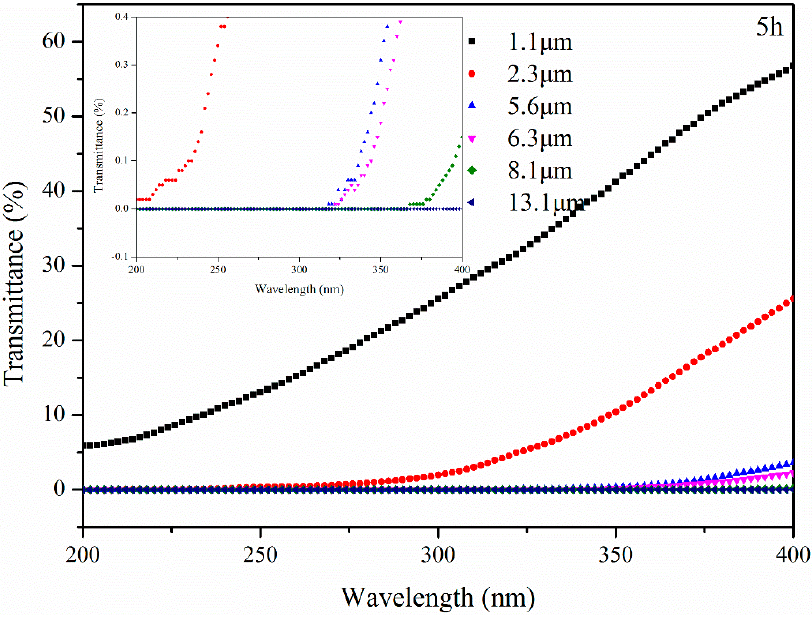
Figure 13. Transmittance of bitumen with different thickness after UV aging for 5 h.